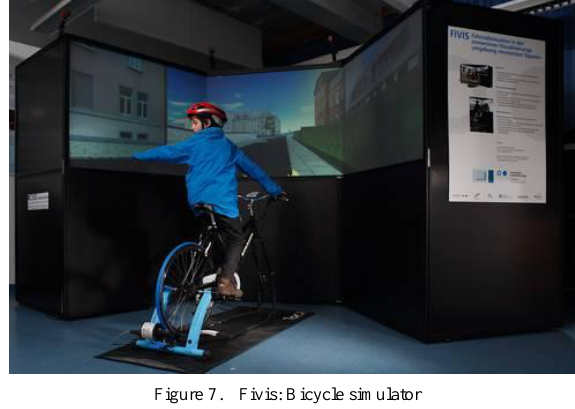
Figure 7. Fivis: Bicycle